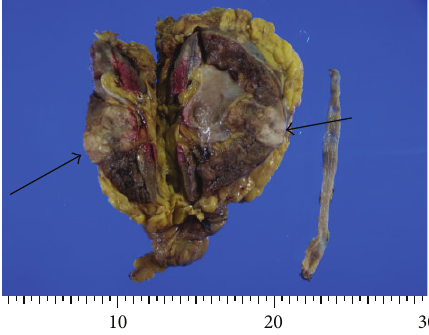
Figure 2: Macroscopic findings of the resected right kidney and ureter. A solid well-demarcated white tumor (arrows) measuring 1.4 × 1.6 × 1.8 cm is seen in the parenchyma. The renal pelvis and ureter show no